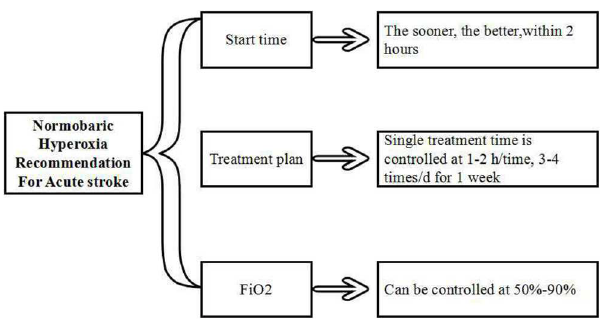
FIGURE 3 | Protocol of NBHO use in